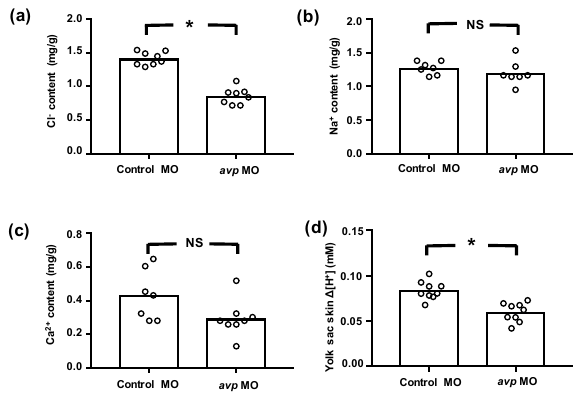
Figure 4. E ff ects of downregulating Avp on ion content or e ffl ux at 3 dpf. Embryos were injected with control morpholino (Control MO) or antisense avp morpholino ( avp MO) at the 1–2-cell stage. Mean values for whole body Cl − ( a ), Na + ( b ), and Ca 2 + ( c ) contents of 8 samples (10 embryos each) are shown in the histograms, with individual values indicated by white circles. Cl − content was determined by spectrophotometer at 460 nm upon reaction with mercury thiocyanate and iron alum. Na + and Ca 2 + contents were measured by atomic absorption spectrophotometry. H + flux gradients ( d ) between skin surface on yolk sac and nearby bu ff er (by a 10 mm-distance horizontally) were determined by the scanning ion-selective electrode technique (SIET). A positive H + gradient ( ∆ [H + ]) representing acid secretion was recorded at the surface of the yolk sac. Values are means ( n = 8–9). Asterisks indicate significant di ff erences from control, according to Student’s t -test, p < 0.05. NS indicates no significant di ff erence.